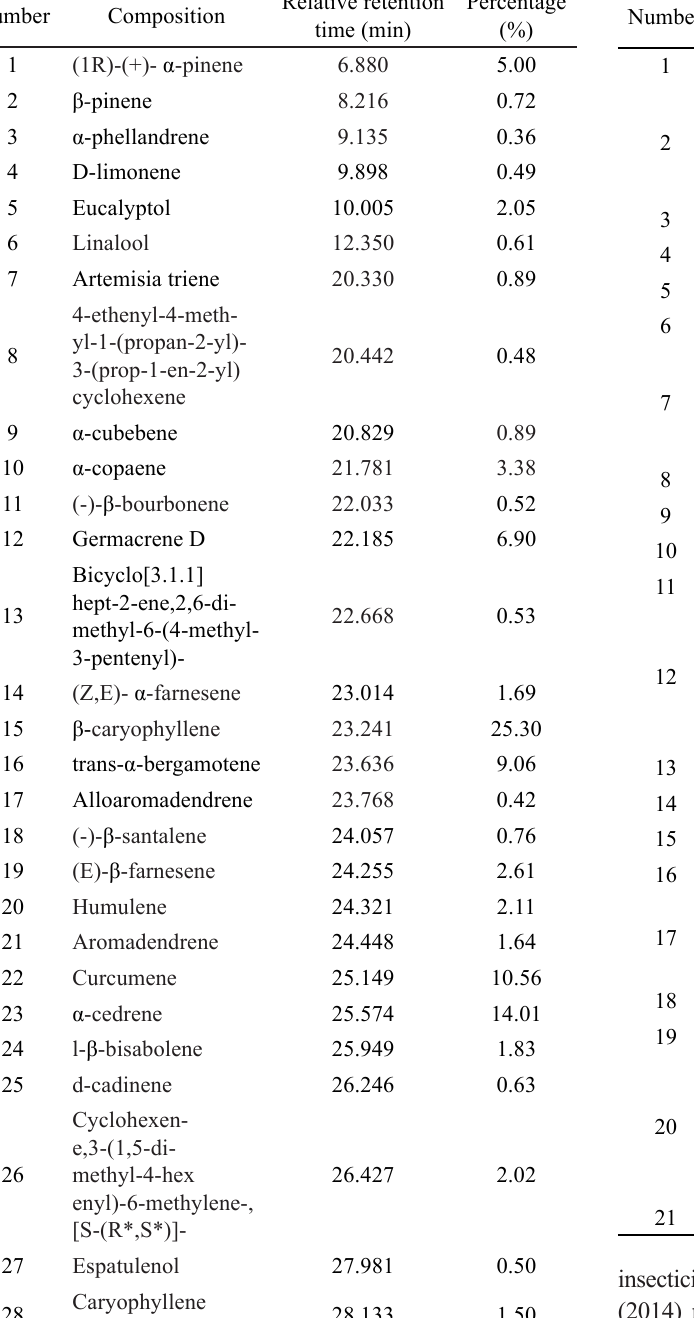
Table 8. Chemical compositions from mashed dried leaves of M. exotica.